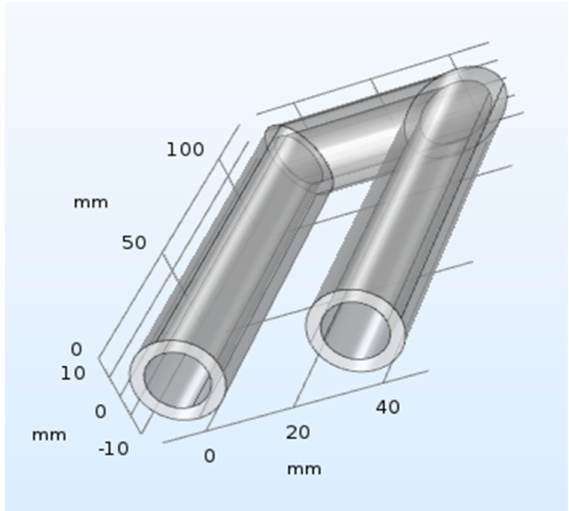
Figure 9. Geometry of the exchanger